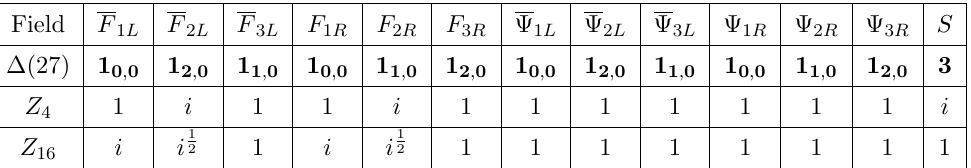
Table 2 . Transformation properties of the leptons and quarks under the (cid:13)avor symmetry (cid:1)(27) (cid:10) Z 4 (cid:10) Z 0 4